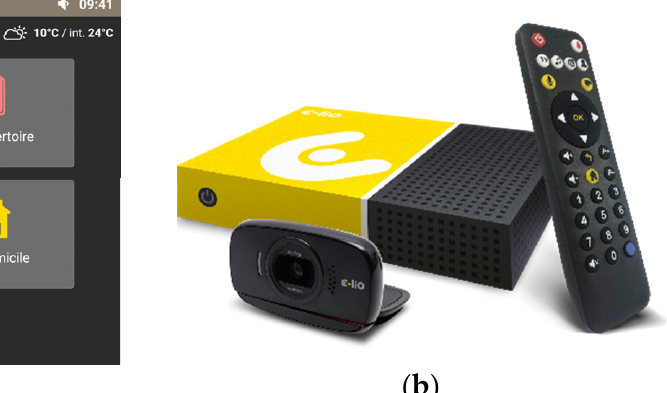
Figure 2. Task diagrams representing the processes for: ( a ) making a video call; ( b ) checking a message on the DiTV.